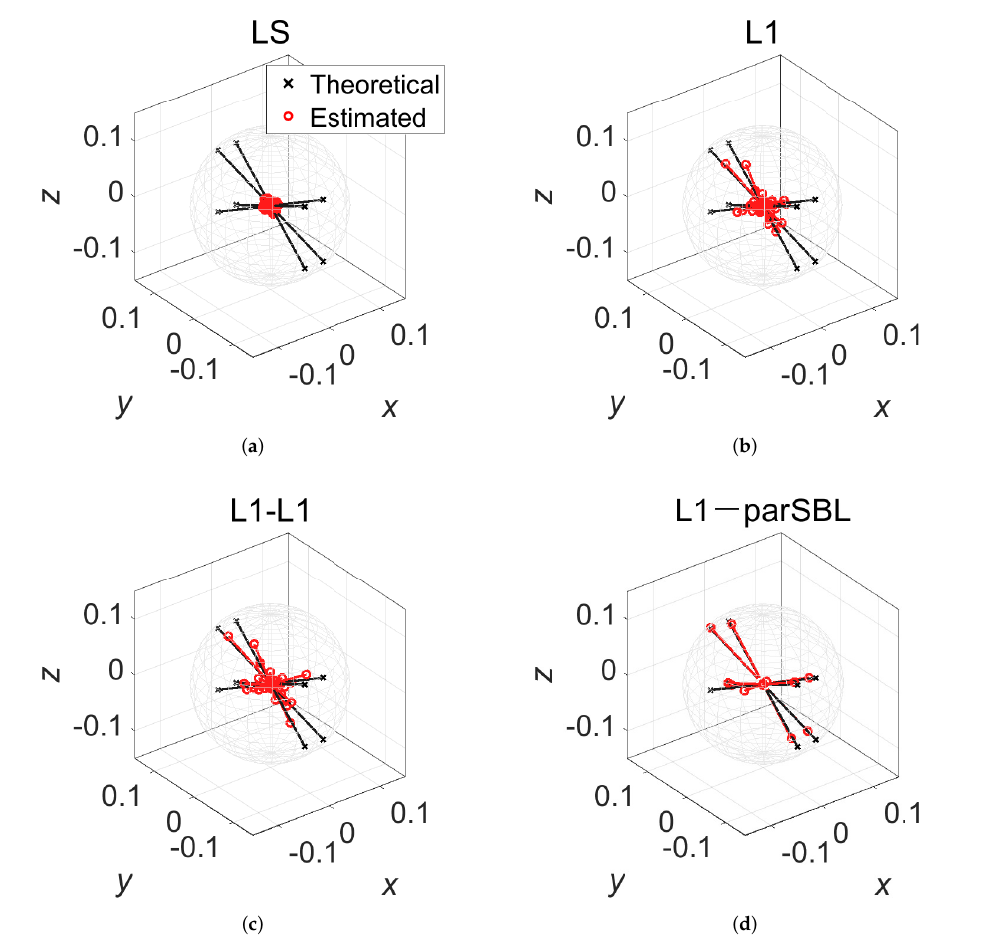
Figure 5. (Color online) Comparison between the theoretical and estimated PWs obtained using ( a ) LS ( R = 400), ( b ) L1 ( R = 400), ( c ) L1-L1 ( R (cid:48) = 23), and ( d ) L1-parSBL ( R (cid:48) = 23) for the (1, 3, 1) mode. The arrows indicate the PW directions, and their lengths are equal to the absolute